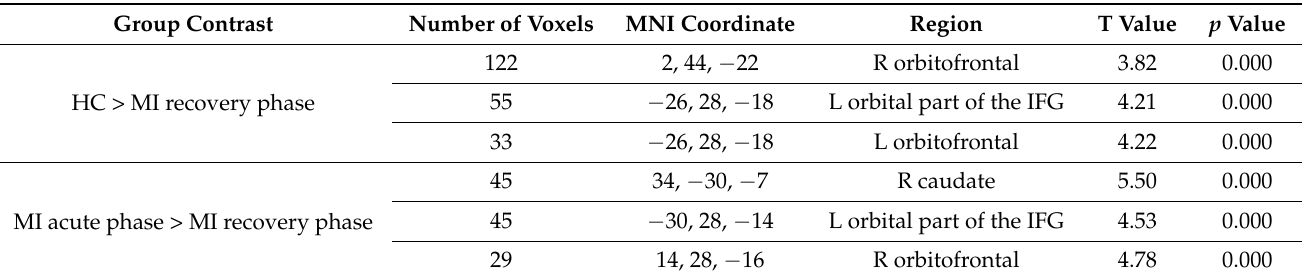
Table 3. Significant group differences between HC and MI while viewing aversive versus positive pictures during the emotional task-based fMRI paradigm.